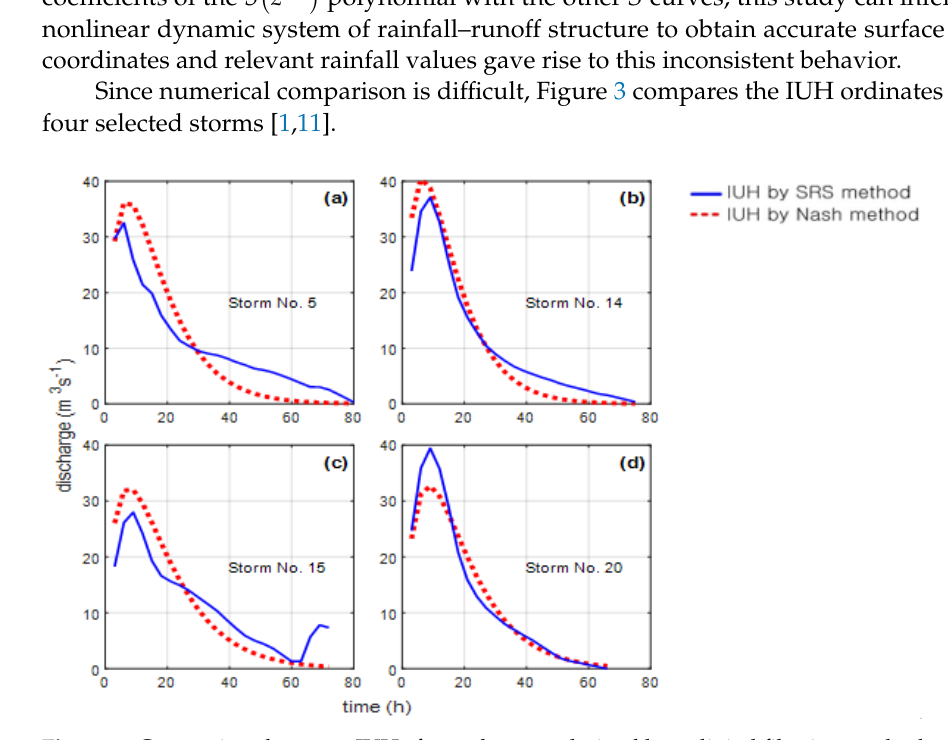
Figure 3. Comparison between IUHs for each storm derived by a digital filtering method using the S-curve from the SRS method and Nash IUHs whose parameters are referenced from prior research: ( a ) for Storm No. 5; ( b ) for Storm No. 14; ( c ) for Storm No. 15; ( d ) for Storm No. 20.